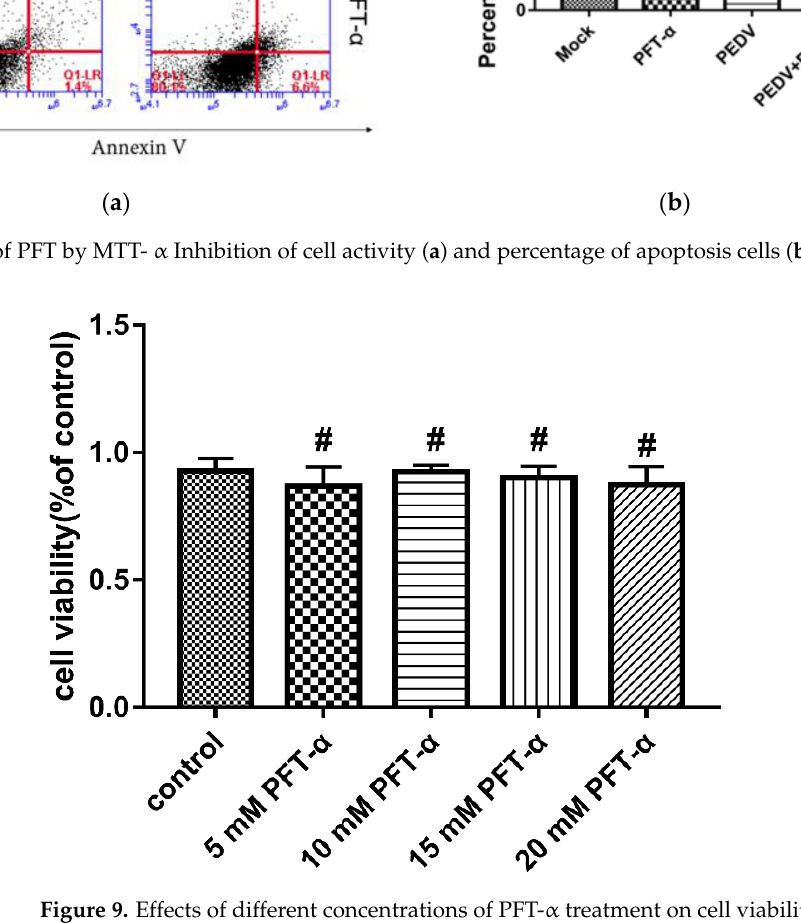
Figure 9. Effects of different concentrations of PFT-α treatment on cell viability (#, p < 0.05.).